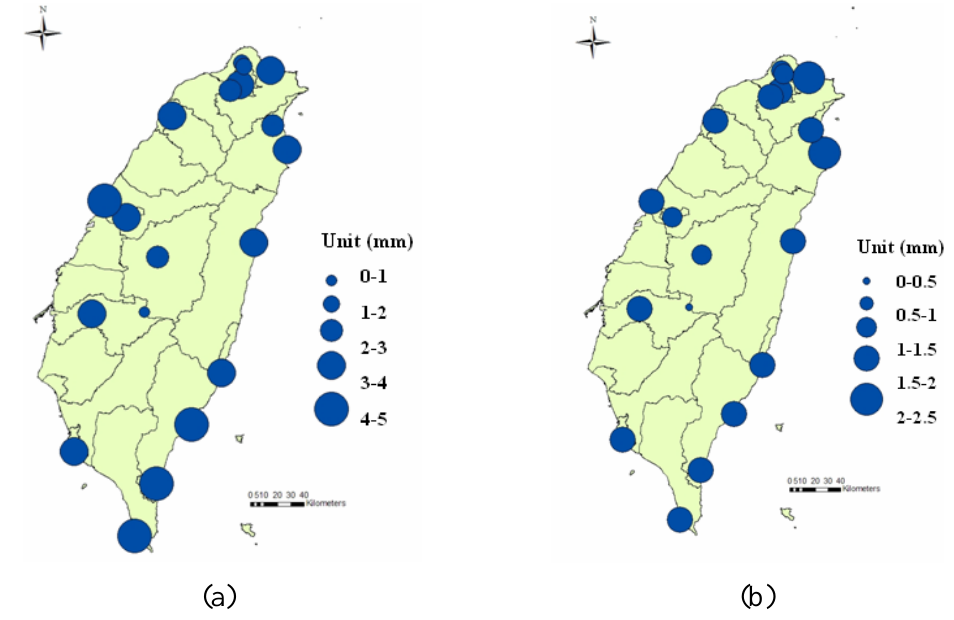
Fig. 4. Statistical features of the spatial distribution of daily pan evaporation in Taiwan: (a) average of evaporation; and (b) standard deviation.